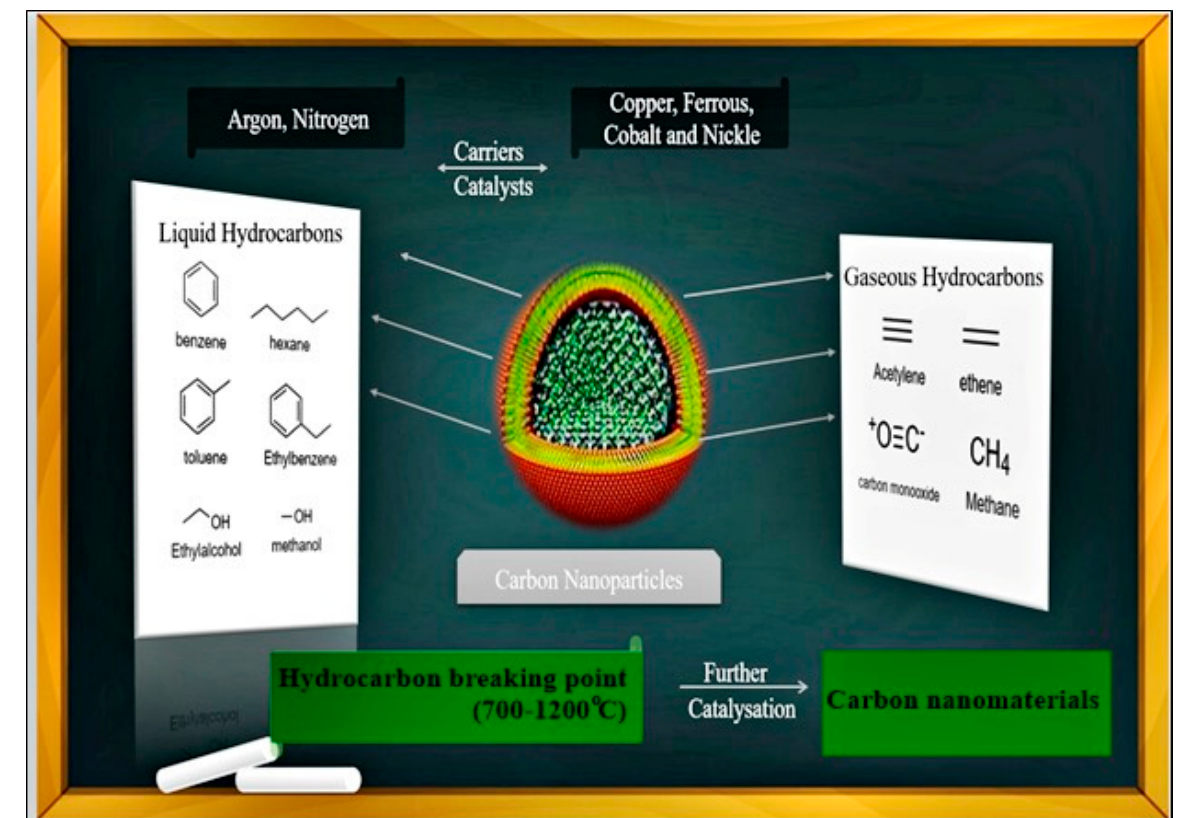
Figure 3. Various liquid and gaseous hydrocarbon fossils utilized for the fabrication of carbon-based NMs at higher temperatures using various metals acting as catalyst.